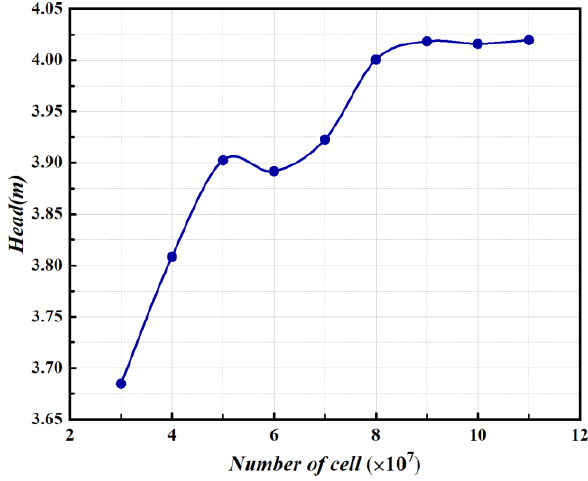
Figure 3. Grid independence analysis.